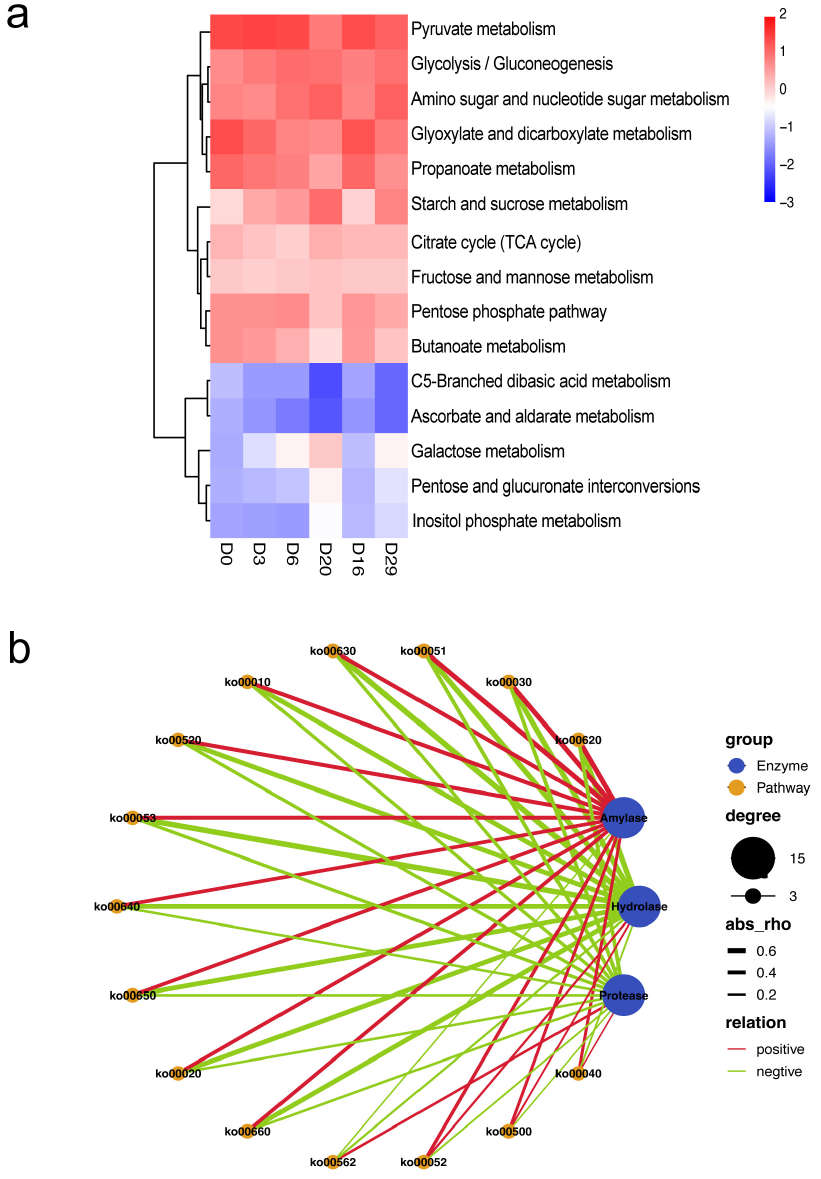
Figure 8. Correlation between functional genes and extracellular enzyme activity. The heatmap of functional gene abundance ( p < 0.05) ( a ), the co-occurrence network of functional genes and carbohydrate metabolism pathways (the orange nodes represent functional genes, the blue nodes represent carbohydrate metabolism pathways, and the thickness of the lines represents the correlation strength) ( p < 0.05) (ko00620: Pyruvate metabolism; ko00630: Glyoxylate and dicarboxylate metabolism; ko00030: Pentose phosphate pathway; ko00010: Glycolysis/Gluconeogenesis; ko00052: Galactose metabolism; ko00051: Fructose and mannose metabolism; ko00640: Propanoate metabolism; ko00520: Amino sugar and nucleotide sugar metabolism; ko00650: Butanoate metabolism; ko00660: C5-Branched dibasic acid metabolism; ko00020: Citrate cycle (TCA cycle); ko00562: Inositol phosphate metabolism; ko00052: Galactose metabolism; ko00500: Starch and sucrose metabolism; ko00040: Pentose and